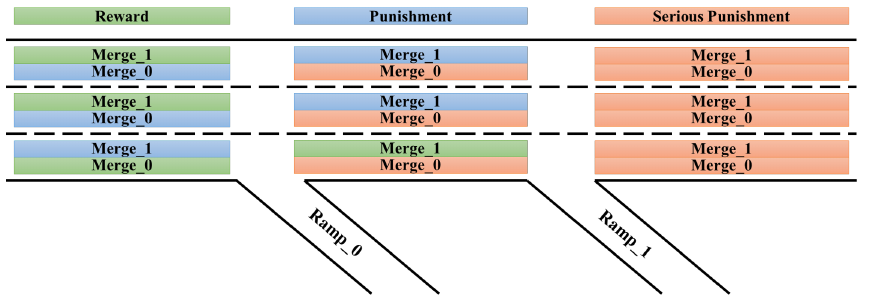
Figure 6. Intention reward gradient diagram. The task completion of autonomous vehicles is seen as a factor in judging the quality of the current reinforcement learning model, which is manifested in the reward values that can be obtained when each vehicle is in different driving sections and lanes. The strip area represents the reward types that the corresponding vehicles can obtain from the area. Green represents reward (1 × R I − Base ), blue represents punishment ( − 1 × R I − Base ), and orange represents serious punishment ( − 2 × R I − Base ). R I − Base is set to 1 for